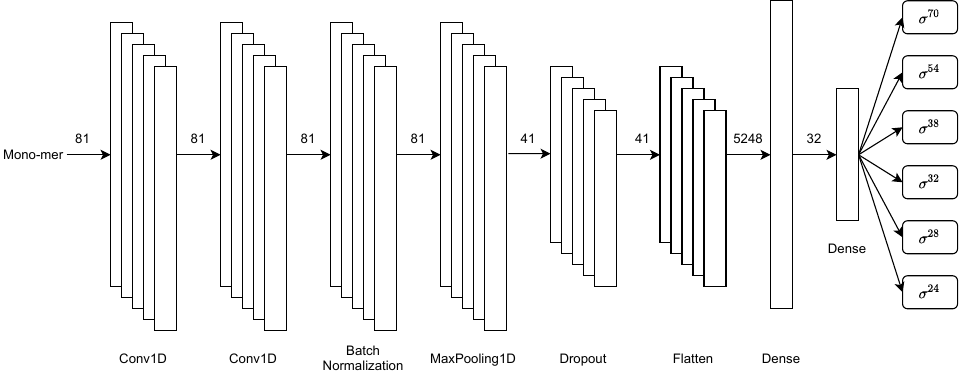
Figure 4. Second-stage multiclass CNN architecture for sigma classification in PromoterLCNN.